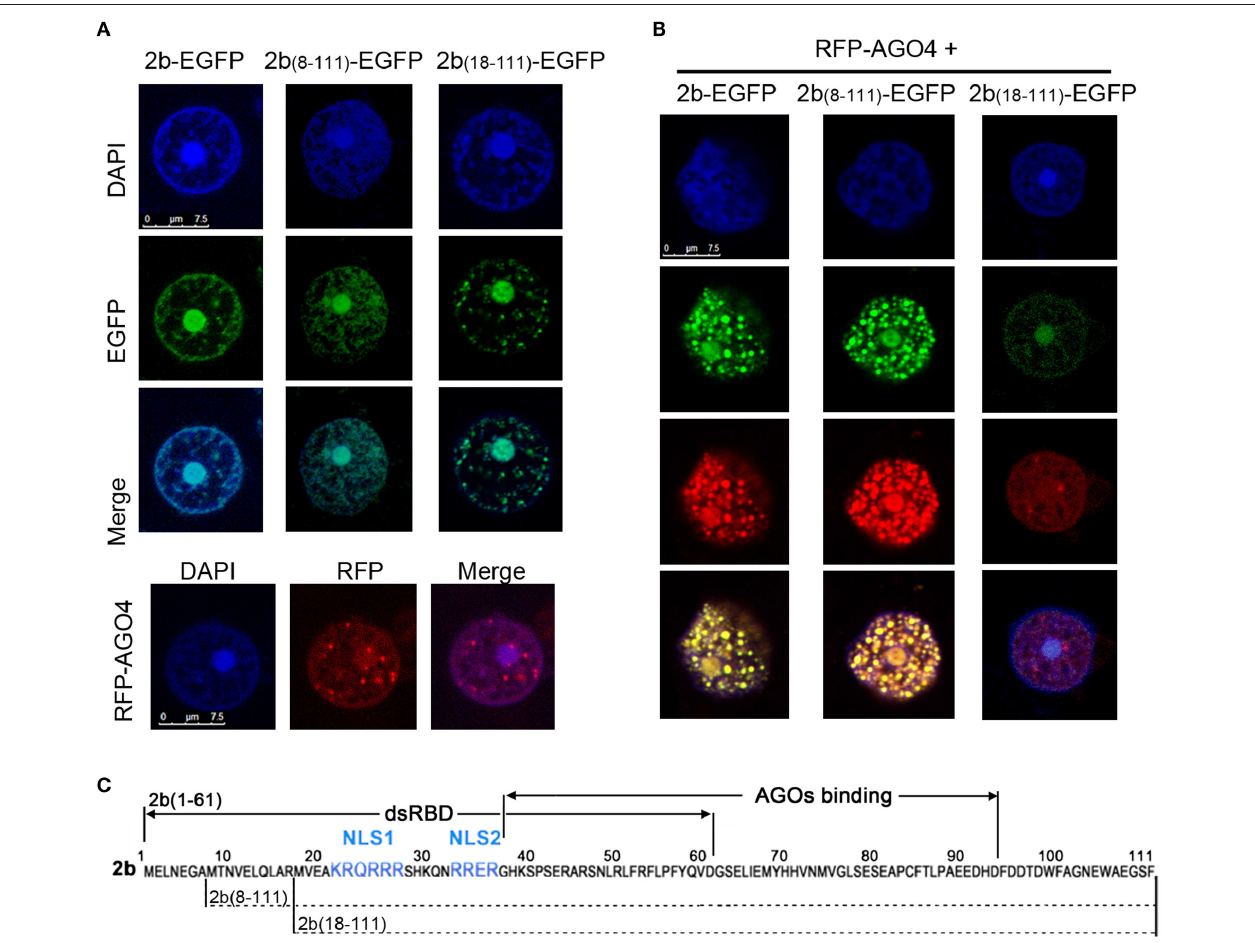
FIGURE 3 | Colocalization pattern of 2b or its derivative mutants with AGO4 in Nb leaf epidermal cells. (A) Subcellular localization of 2b-EGFP, 2b (8 – 111) -EGFP, 2b (18 – 111) -EGFP, and RFP-AGO4 in Nb leaf epidermal cells. DAPI staining was performed to represent the nuclei. Bars = 7.5 µ m. (B) Subcellular location of the coexpression of 2b-EGFP, 2b (8 – 111) -EGFP, or 2b (18 – 111) -EGFP with RFP-AGO4. (C) Diagram of the 2b function domain as previously reported ( Duan et al., 2012 ). NLS, nuclear localization